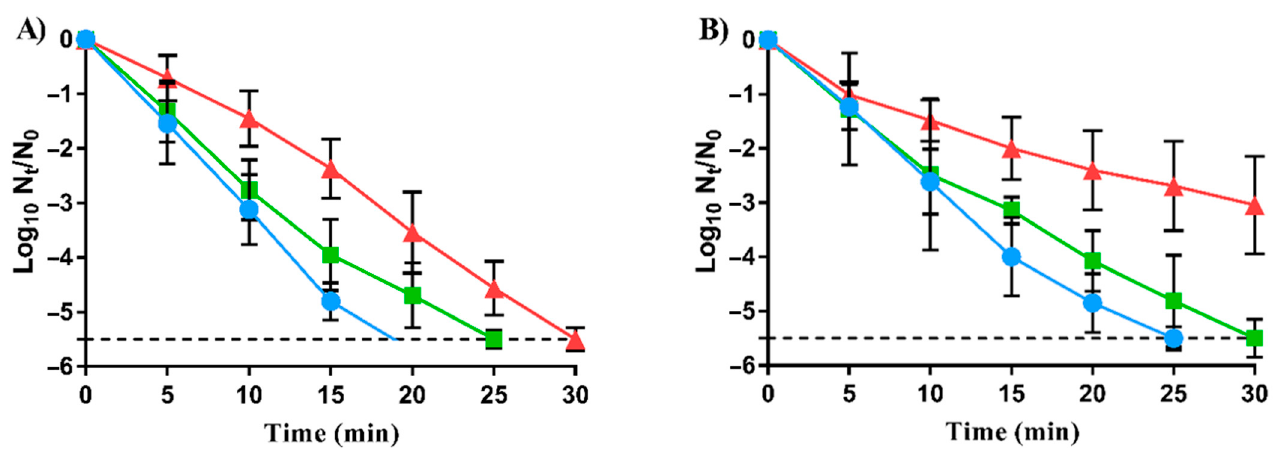
Figure 1. Survival curves of Listeria monocytogenes EGD-e ( ● ; LmWT) and its evolved strains, LmSCar ( ■ ; exposed to prolonged sublethal doses of carvacrol) and LmLCar ( ▲ ; cyclically exposed to short lethal treatments of carvacrol), to 200-µL/L carvacrol treatment at pH 4.0 ( A ) and 300-µL/L carvacrol treatment at pH 7.0 ( B ). Data are means ± standard deviations (error bars) obtained from at least three independent experiments. The dashed line represents the detection limit ( − 5.5 log 10 N t /N 0 ).